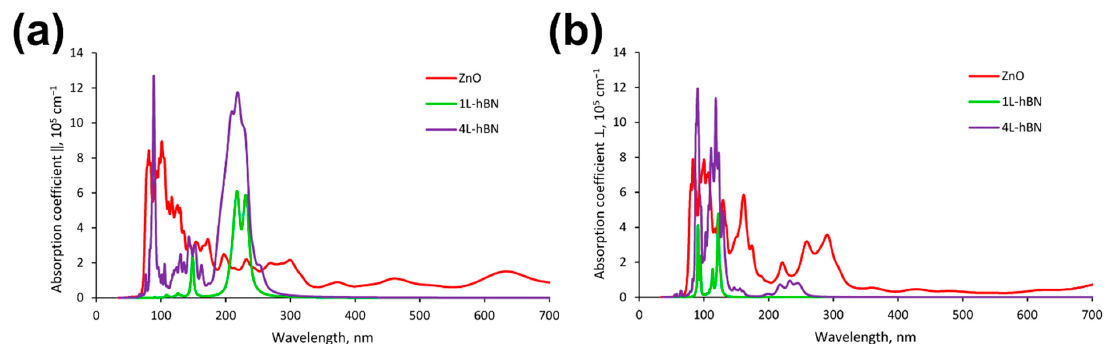
Figure 10. Dependence of the extinction coefficient of individual components of wZnO/h-BN heterostructures on the irradiation wavelength in ( a ) transverse and ( b ) perpendicular directions to the surface.